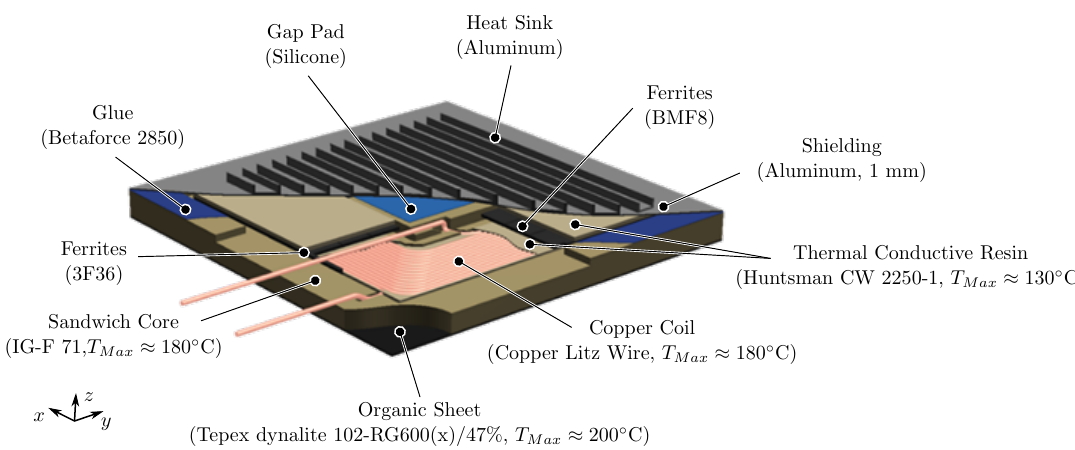
Figure 5. Sandwich concept and maximum temperature ratings of the